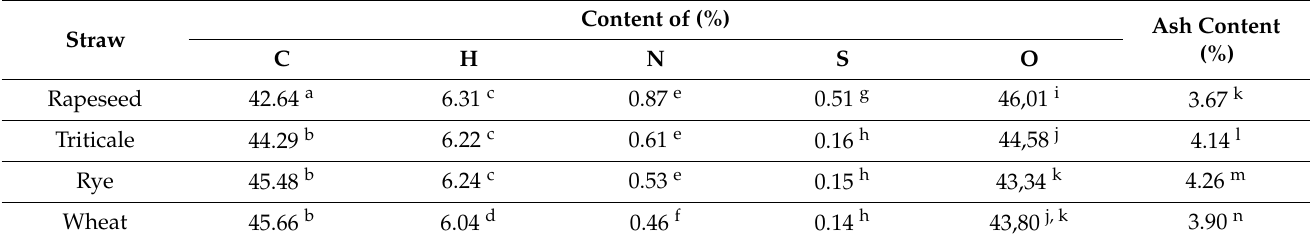
Table 5. Chemical composition of the straw from various sources of harvesting.